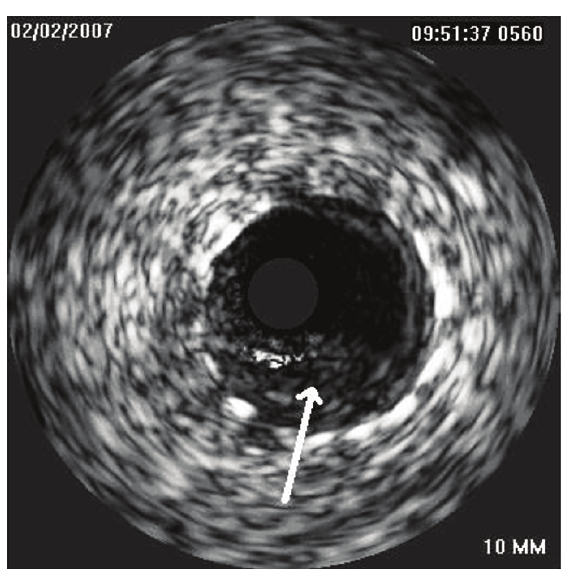
Figure 1. Intravascular ultrasound (IVUS) image of the mural thrombus (arrow) inside the implanted stent.